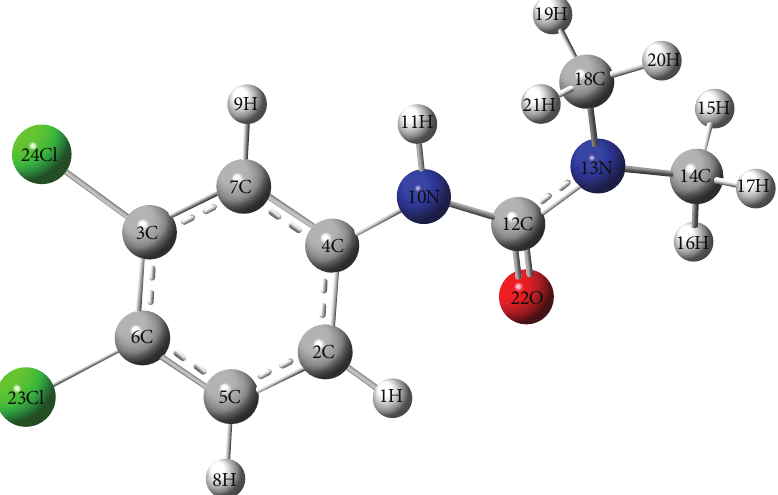
Figure 3: Optimized structure of diuron at the MP2/6-311++G(2d,2p) level of theory. Bond distances: 2C-4C = 1.40, 2C-5C = 1.39, 3C-6C = 1.40, 3C-7C = 1.39, 4C-7C = 1.40, 5C-6C = 1.39, 6C-23Cl = 1.74, 3C-24Cl = 1.74, 4C-10N = 1.40, 10N-12C = 1.40, 12C-22O = 1.24, 12C-13N = 1.36, 13N-18C = 1.46, 13N-14C = 1.46, N-H = 1.00, C-H = 1.09 in methyl groups, and C-H = 1.08 in the ring. Dihedral angle 2C-4C-10N-12C =